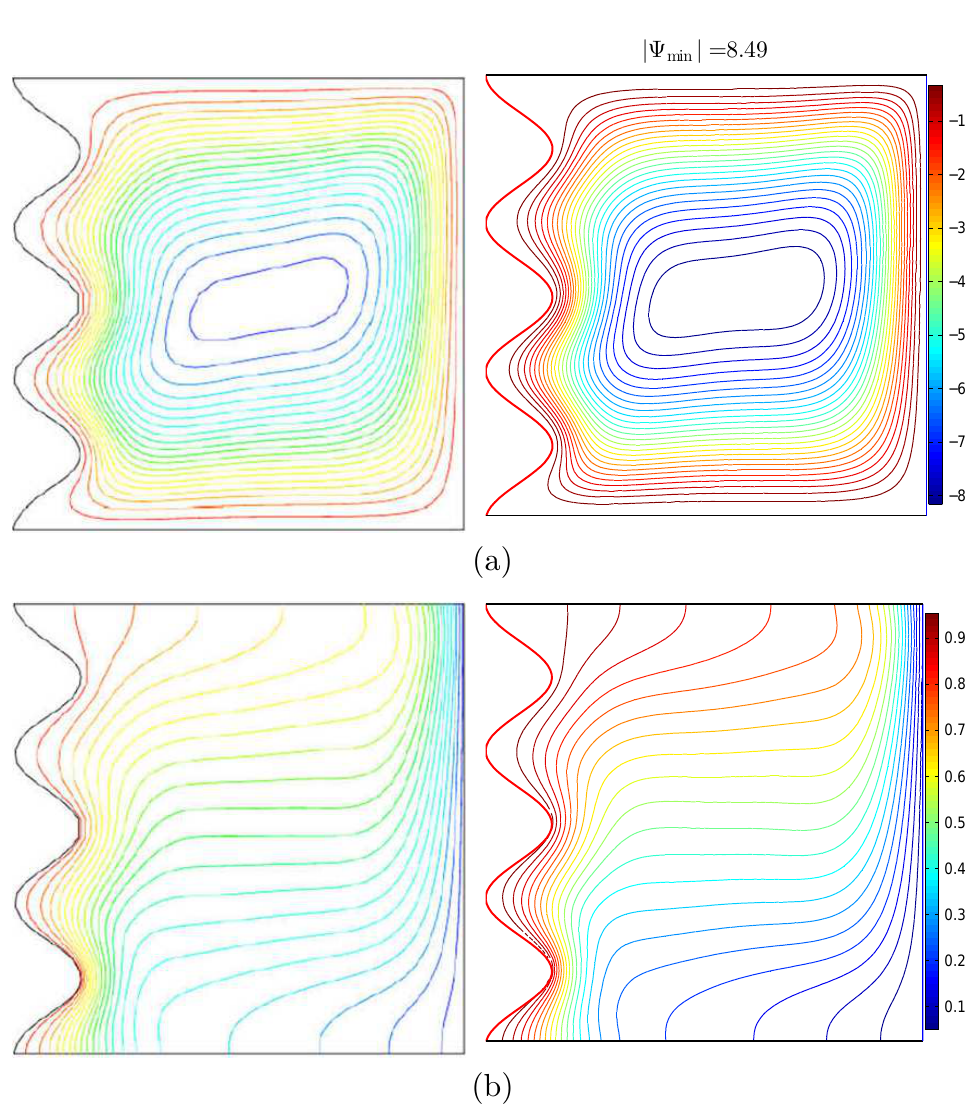
Figure 4. ( a ) Streamlines of ( left ) Khanafer et al. [32] and ( right ) the present study; ( b ) isotherms of ( left ) Khanafer et al. [32] and ( right ) the present study for Ra = 10 5 , Da = 10 − 2 , ε = 0.9, N = 3, D = 0, and Pr =